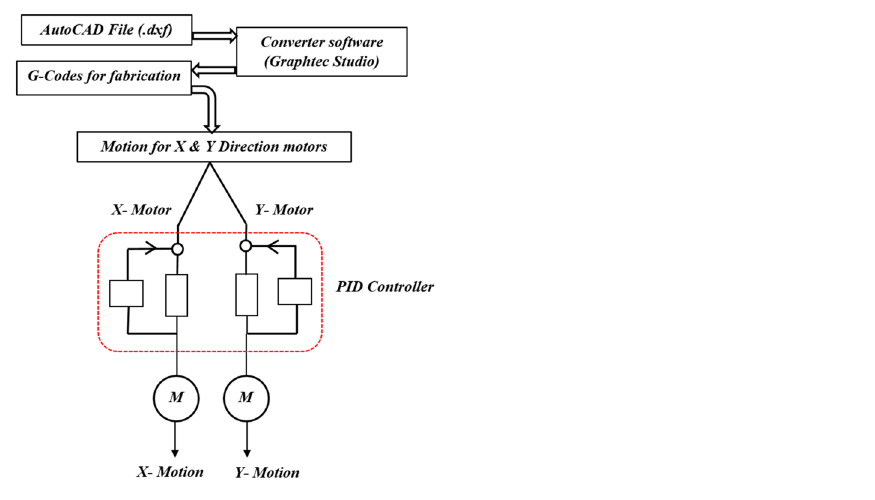
Figure 8. The outline representation of graphite electrodes fabrication with graphtec plotter